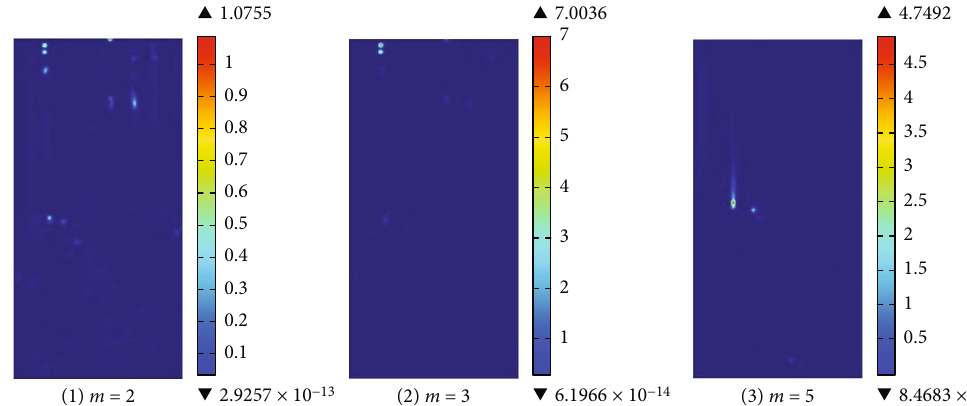
Figure 7: Strain energy density distribution of microelement of rock mass with di ff erent